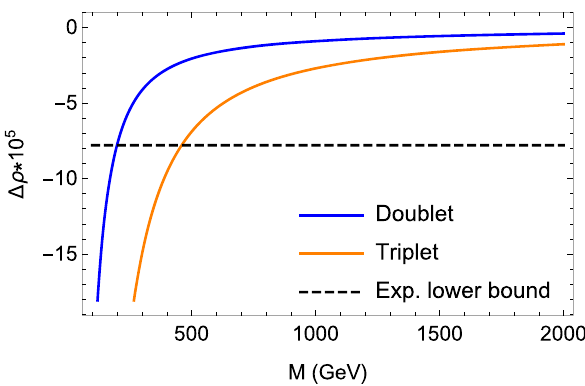
Fig. 2 Excited lepton doublet (blue line) and triplet (orange line) con- tributions to (cid:2)ρ as a function of excited lepton mass M . Dashed black line shows the experimental lower bound on (cid:2)ρ